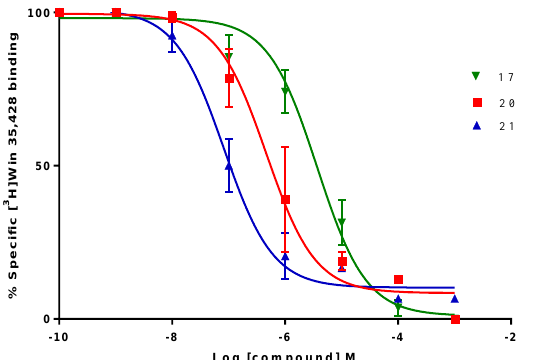
Figure 6. Graph obtained for the displacement experiment of [ 3 H]-WIN 35428. Data points represent the mean ± SEM of four experiments, each one carried out in triplicate. The radioligand concentration in all displacement studies was 1 nM.